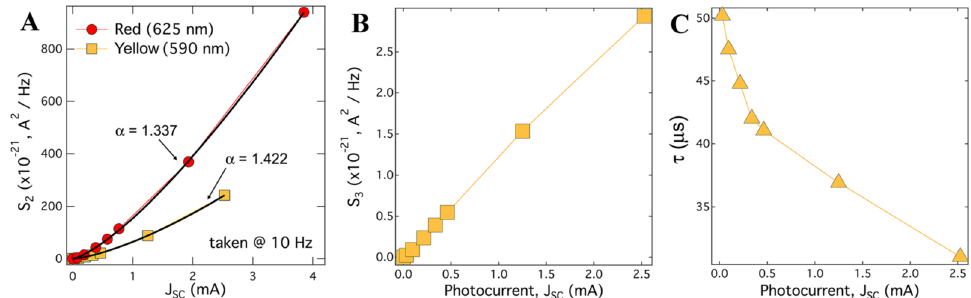
Figure 4. Extracted parameters from current noise spectra shown in Fig. 3. ( A ) The magnitude of the low frequency 1 / f noise at 10 Hz as a function of short-circuit current for illumination with red and yellow light. The black curves represent fits to a power law, S 2 = A × J a SC . ( B ) The magnitude of the generation-recombination term GR1 extracted from a fit to Eq. (3) as a function of J SC ; the value of the exponent of the generation- recombination term is b = 0.21. ( C ) The GR1 time constant plotted as a function of J SC .